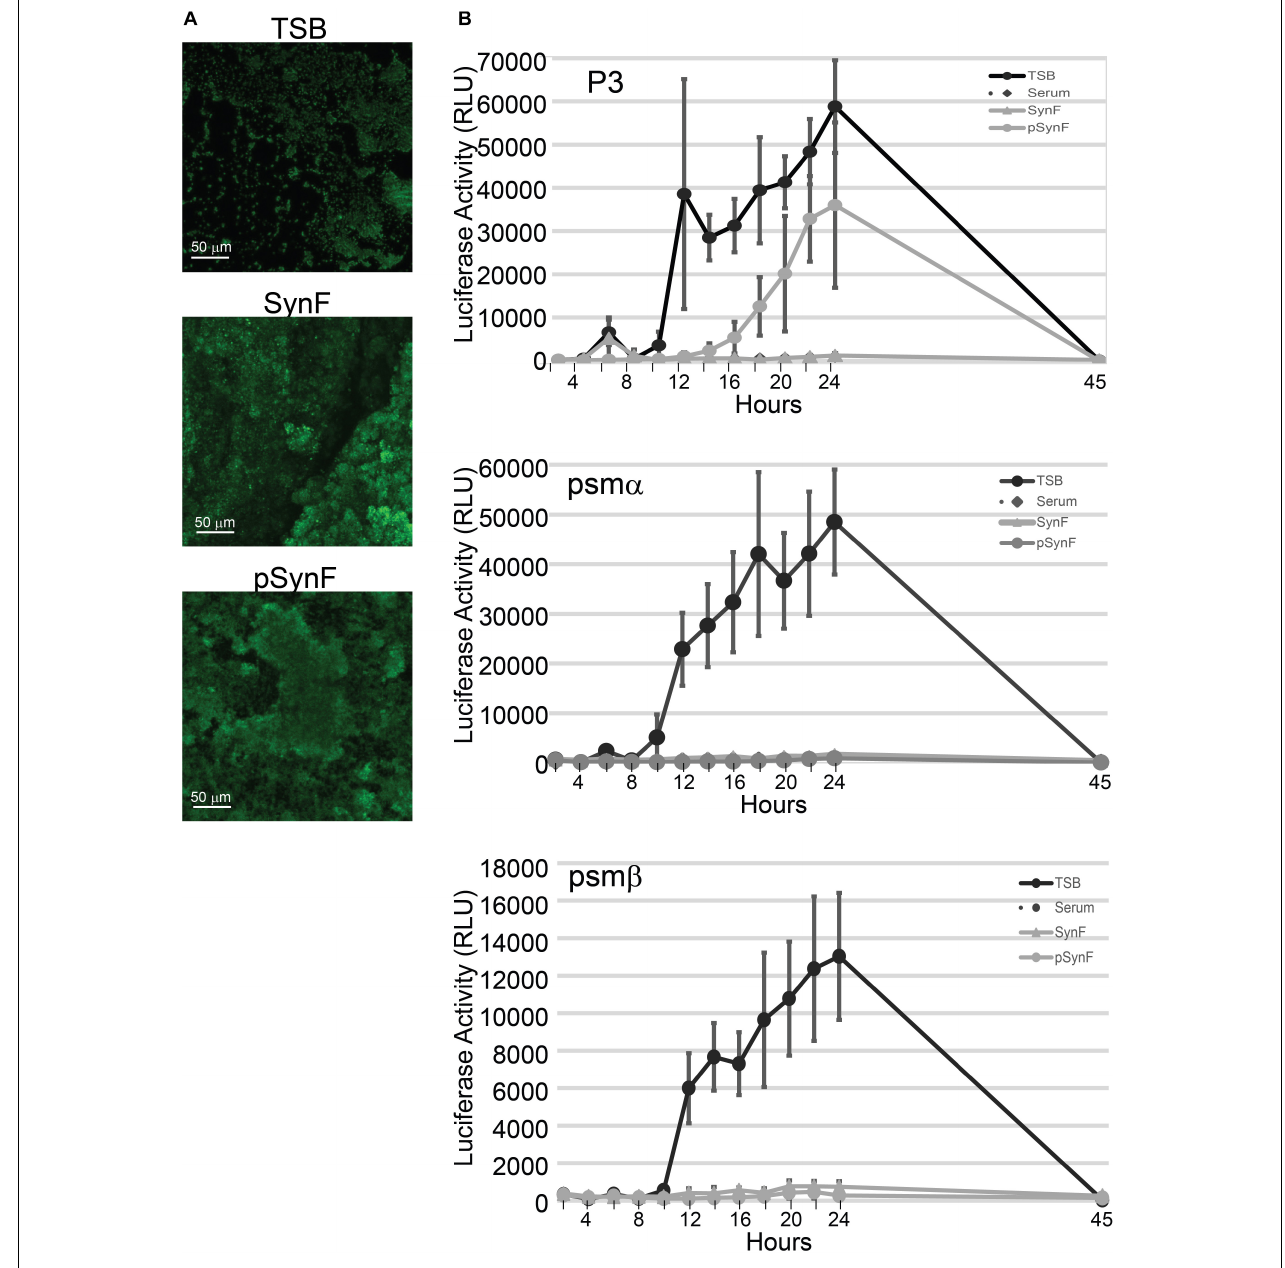
FIGURE 5 | Biofilm and virulence factor expression as a function of medium. (A) Comparison of wheat germ agglutinen staining of polysaccharide intercellular adhesin (PIA) in methicillin-susceptible Staphylococcus aureus (MSSA) grown in Trypticase Soy Broth (TSB), pooled synovial fluid, or pseudo synovial fluid (pSynF). (B) Expression of luciferase under control of P3, psm α , or psm β promoters using MRSA LAC300 strains in TSB, serum, pooled synovial fluid, and pSynF. Each line represents the average of three independent experiments performed in duplicate. Values graphed are means ± SD. Statistics are available in Supplementary Material A2